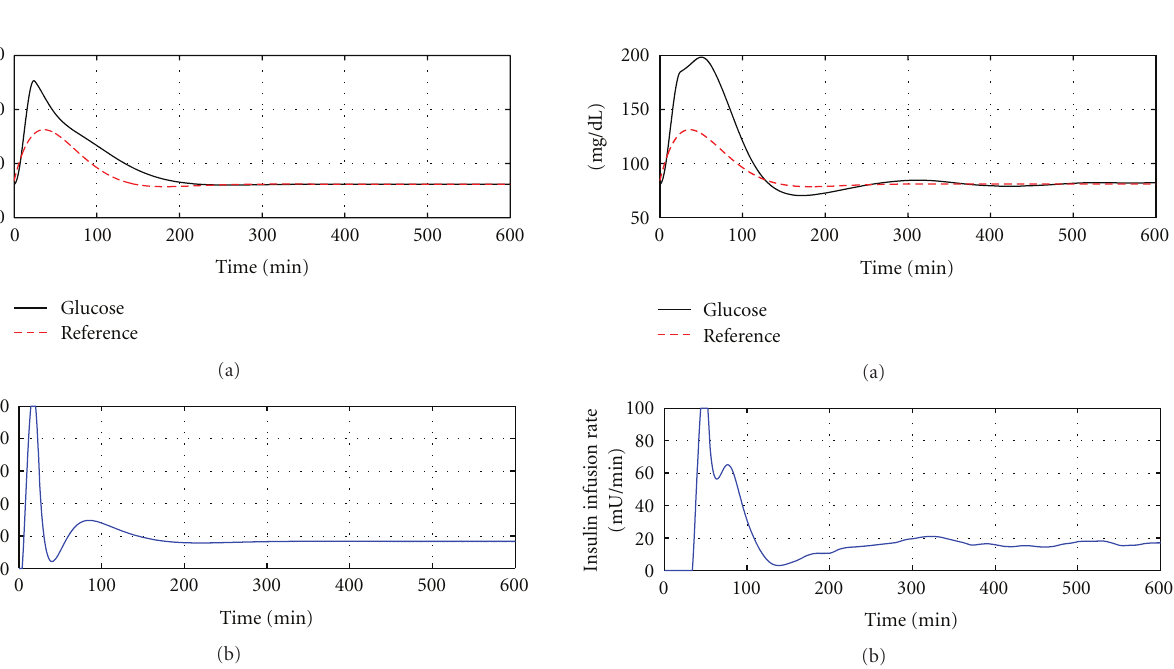
Figure 4: LPV control: glucose monitoring and insulin control.